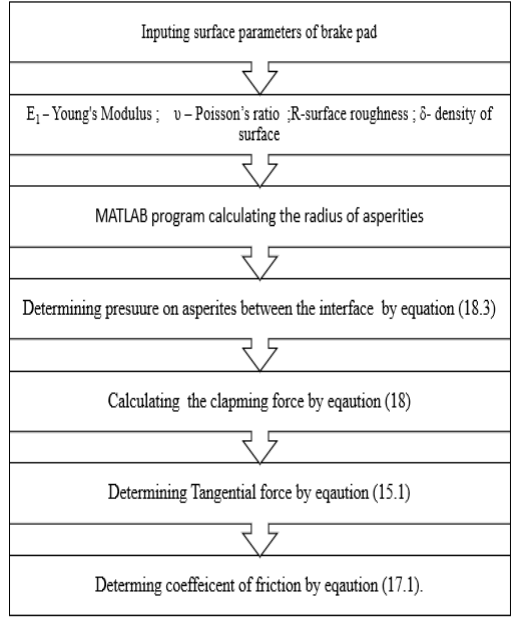
Figure 6. Algorithm for Estimation of